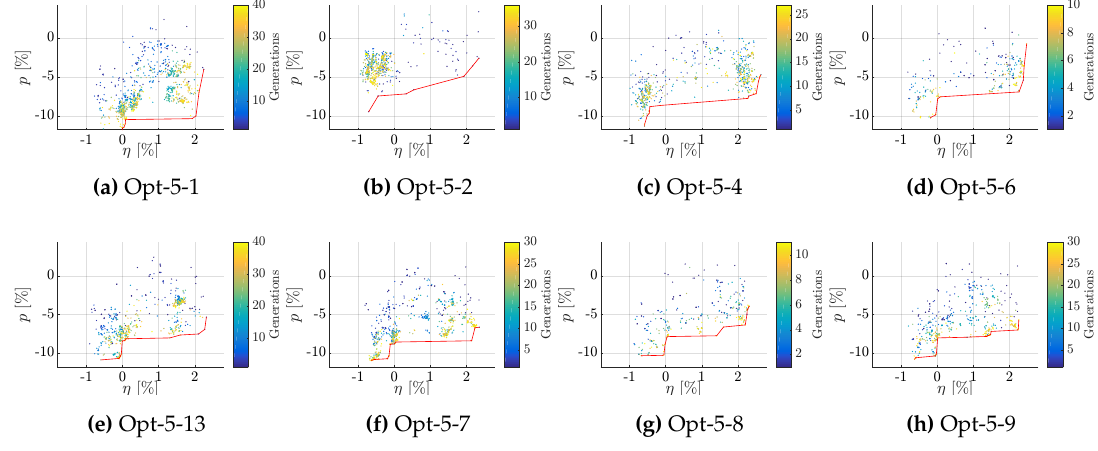
Figure A7. Pareto fronts for Opt-5 for η and pressure pulse objectives (Group 1: ( a – d ); Group 2: ( f – h